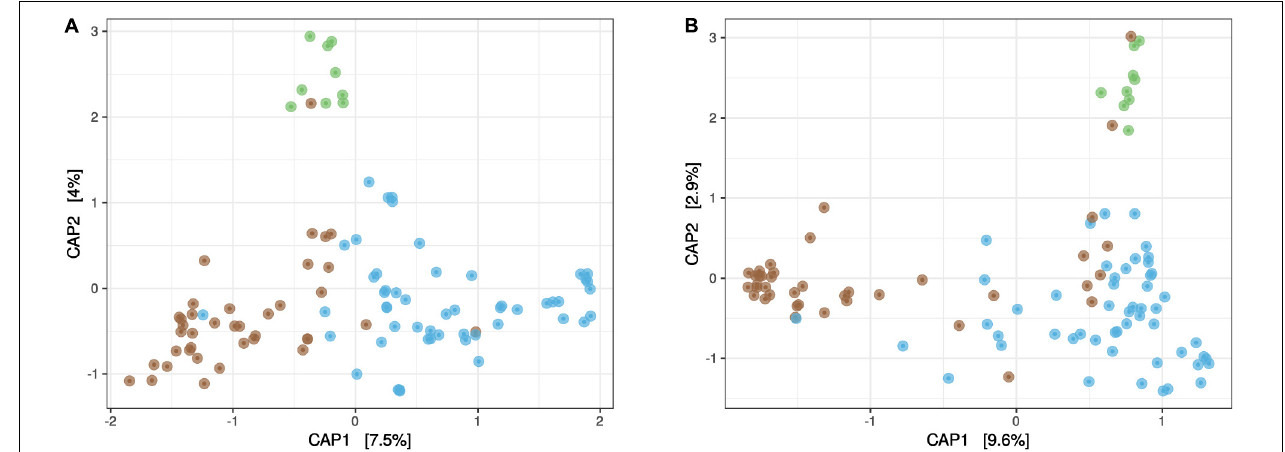
FIGURE 2 | Differences in community composition. Both the prokaryotic community (A) and eukaryotic communities (B) presented significant differences (permutation tests for CAP, P < 0.001) between seawater at tide sites (TS-sw, in blue), Sargassum at marine tide sites (TS-sarg, in brown), and Sargassum at inland storage sites (ISS-sarg, in green).